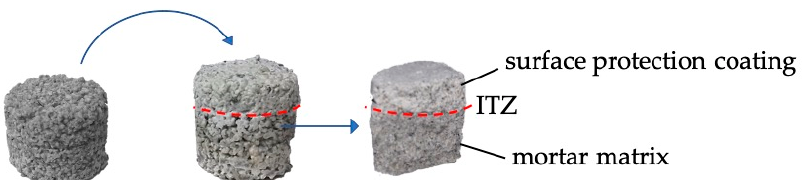
Figure 1. Schematic representation of a mortar before and after the application of the surface protection